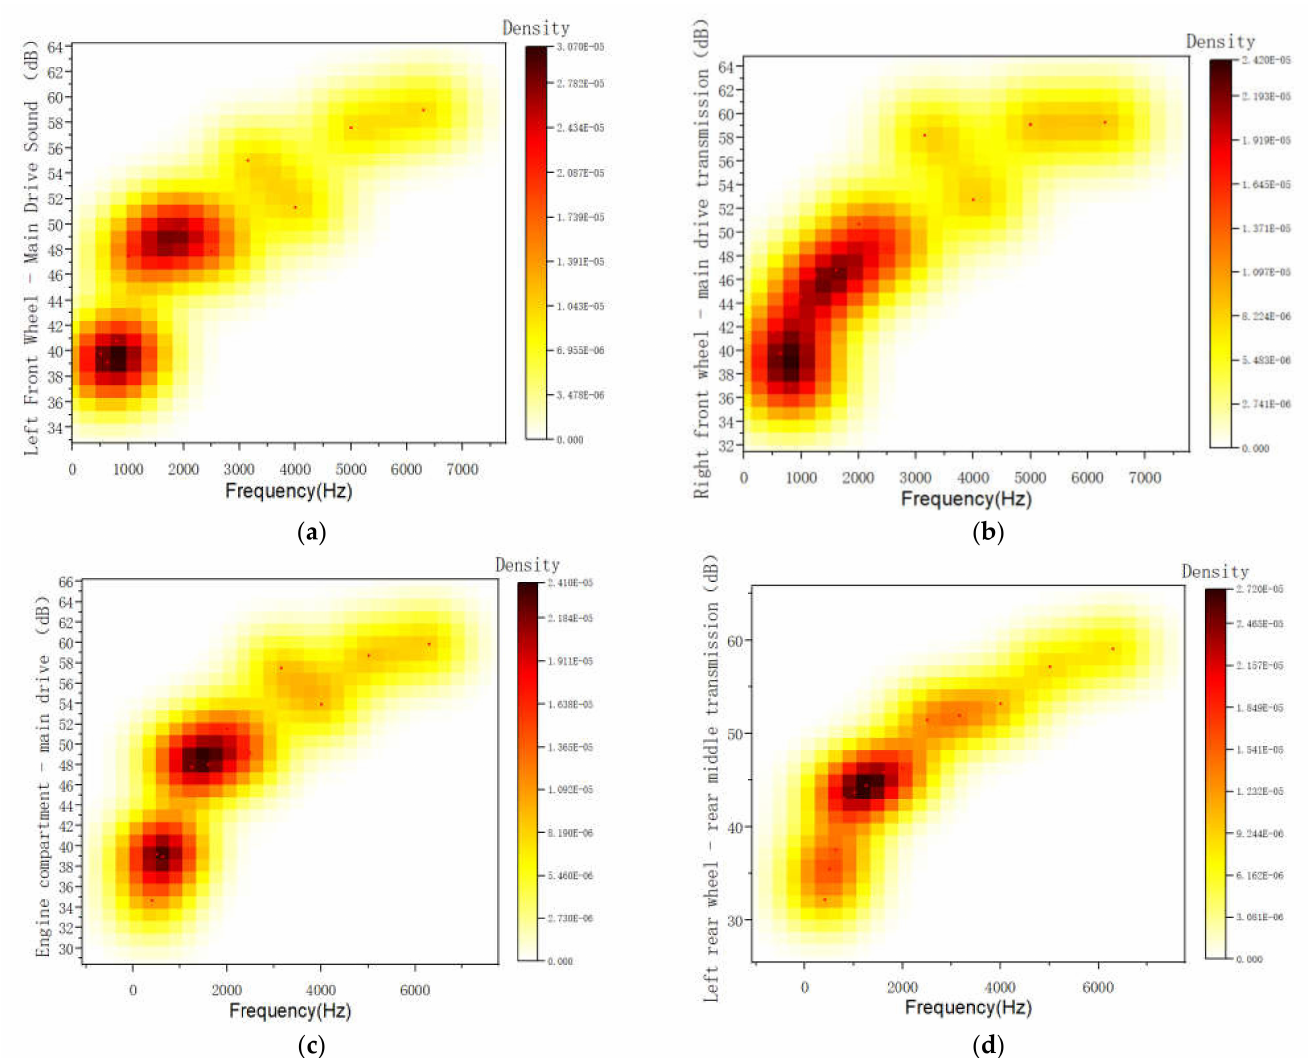
Figure 14. Test results of the acoustic-acoustic transfer function. ( a ) Acoustic-acoustic transfer function under left front wheel excitation; ( b ) Acoustic-acoustic transfer function under right front wheel excitation; ( c ) Acoustic-acoustic transfer function under engine room excitation; ( d ) Acoustic-acoustic transfer function under left rear wheel